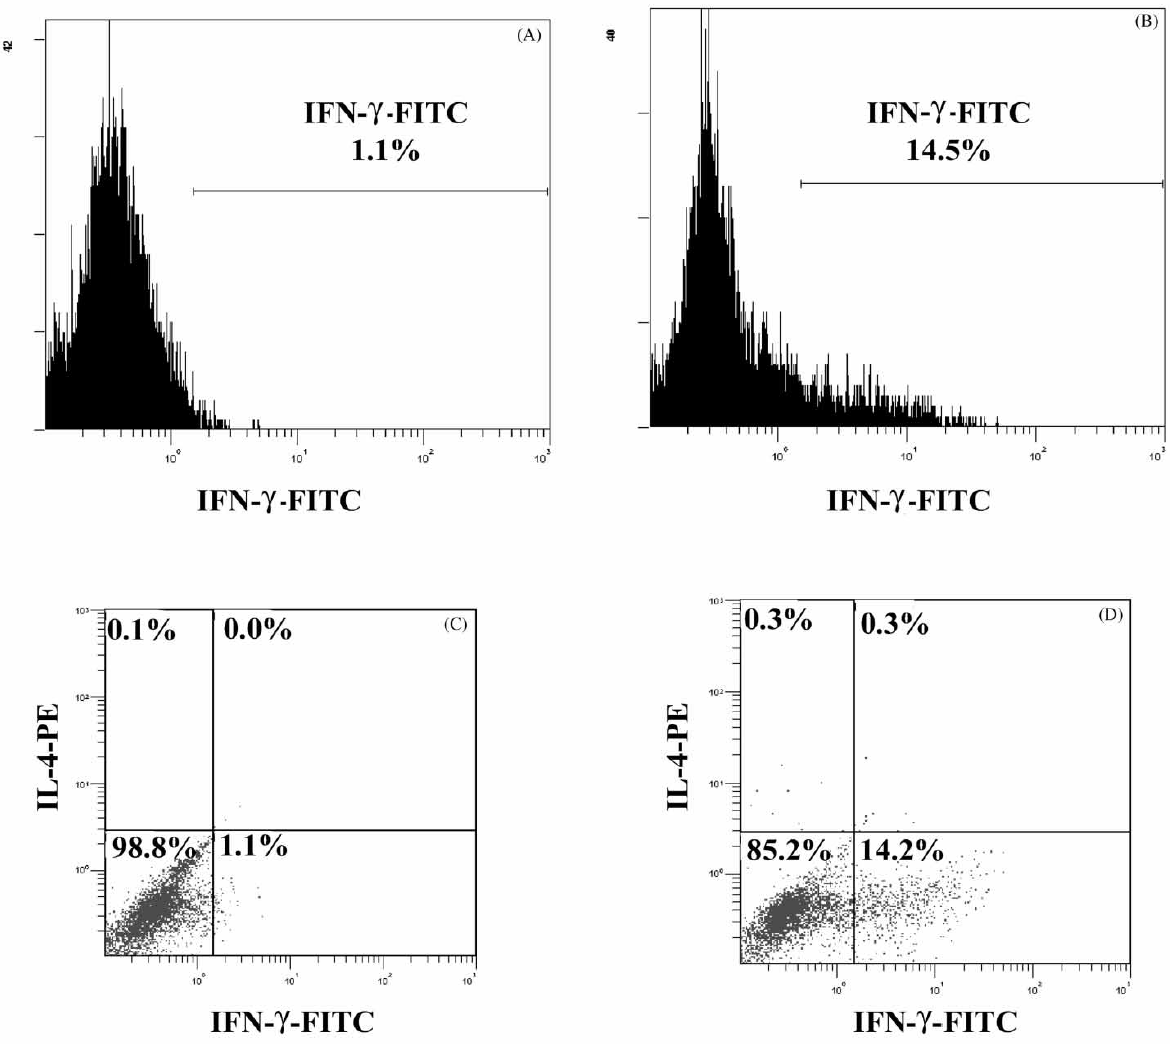
FIG. 2. Creation of a positive cell gate for IFN- g staining. Due to shift in the forward side scatter characteristics of activated cells, it is essential that identically stimulated cells are used as a negative control for cytokine specific staining, and are saturated with 10 x excess unlabelled antibody (of the same isotype) prior to and during staining with the fluorochrome conjugate. Using this unlabeled negative control sample, cell gates are drawn on both the histogram (A) and the quadrant markers (B) such that only (cid:1) / 1.0% of the cells are measured as being positive for the cytokine gate. An identically stained sample, without the addition of the 10 x excess of unlabelled antibody, is then run to determine whether the positive control is in fact positive, and to establish FACS compensation settings (C and D). During later analysis, the ‘background’ per cent of cells gated positive in the unlabelled negative control is subtracted from the value of the samples measured as